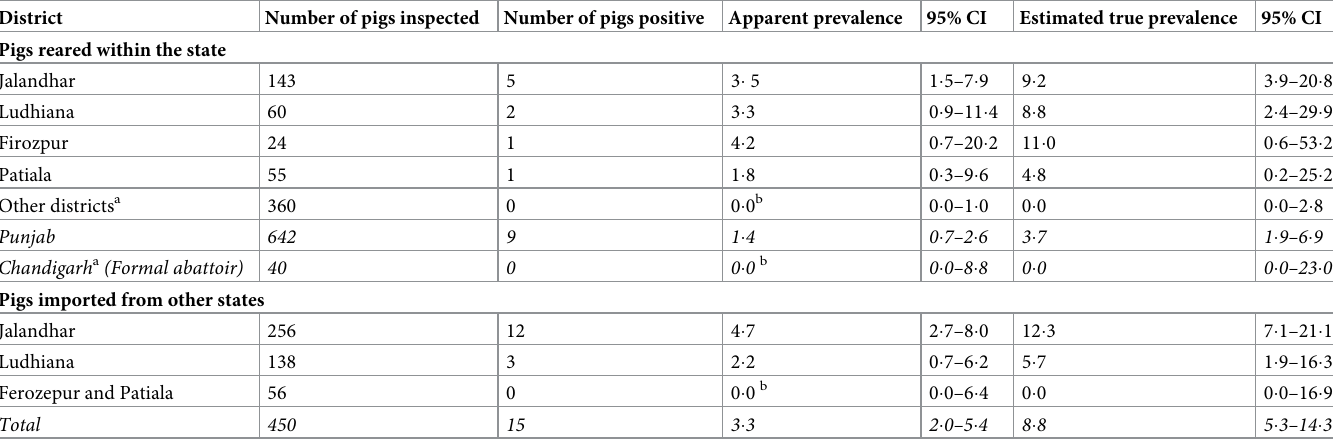
Table 2. Apparent and estimated true prevalence for T . solium cysticercosis in pigs reared in different districts in Punjab, India. District Number of pigs inspected Number of pigs positive Apparent prevalence 95% CI Estimated true prevalence 95%